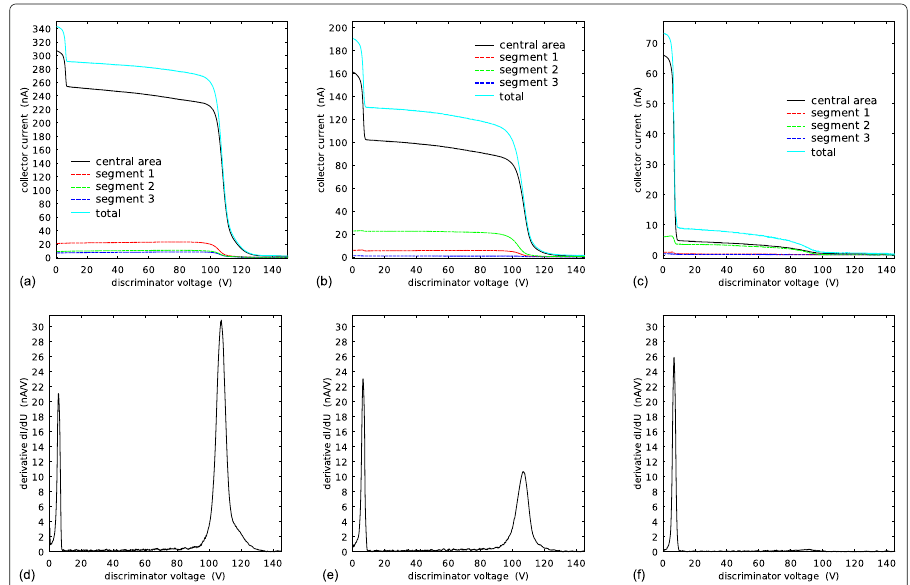
Fig. 11 Demonstration of an RPA measurement in case of an ion distribution function with two populations. The figure parts (a) to (c) show the measured collector currents at the three positions − 0mm, − 40mm, and − 100mm, where the minus indicates the upper half of the chamber in Fig. 5(a). The figure parts (d) to (f) show the corresponding derivatives, respectively. The three columns of plots represent the three positions, i.e. on the beam axis (left), at the beam edge (middle), and clearly outside the beam